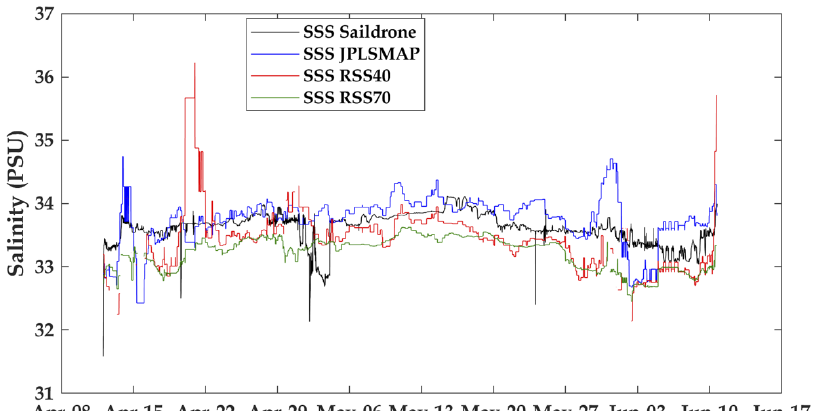
Figure 4. SSS time series from Saildrone CTD, JPLSMAP, RSS40, and RSS70.